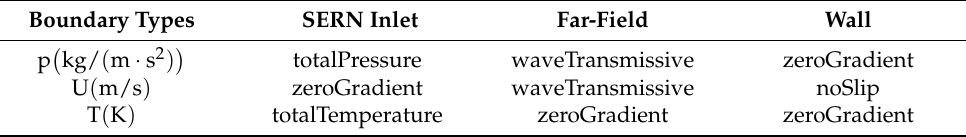
Figure 3. Three-dimensional mesh topology for the present SERN jet with ( a ) boundary conditions; ( b ) zoomed-in view on cross-stream grid. ( c ) zoomed-in view on streamwise grid. Table 1. Boundary conditions for the numerical simulations of SERN jet flows using